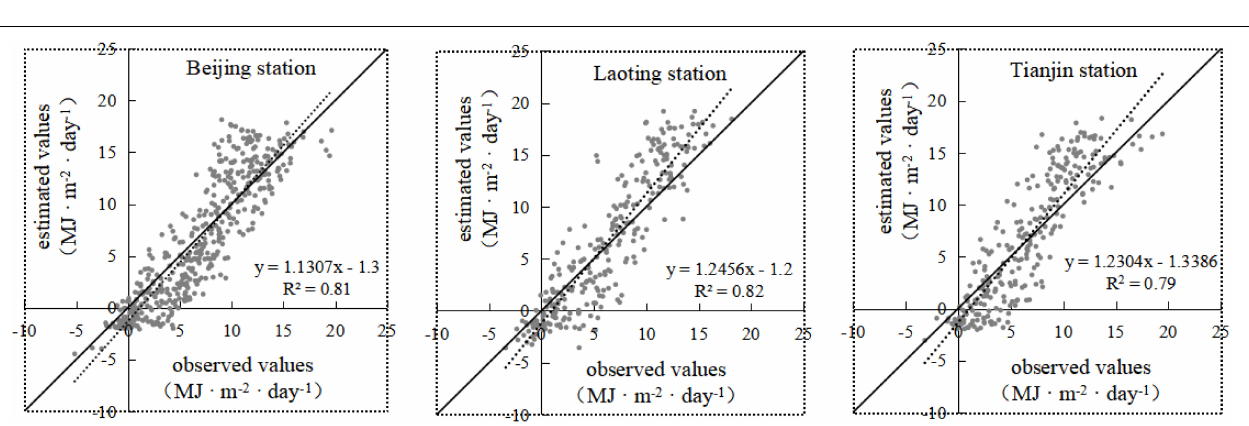
FIGURE 7 | Comparison of estimated and observed daily net radiation of the Haihe River Basin.